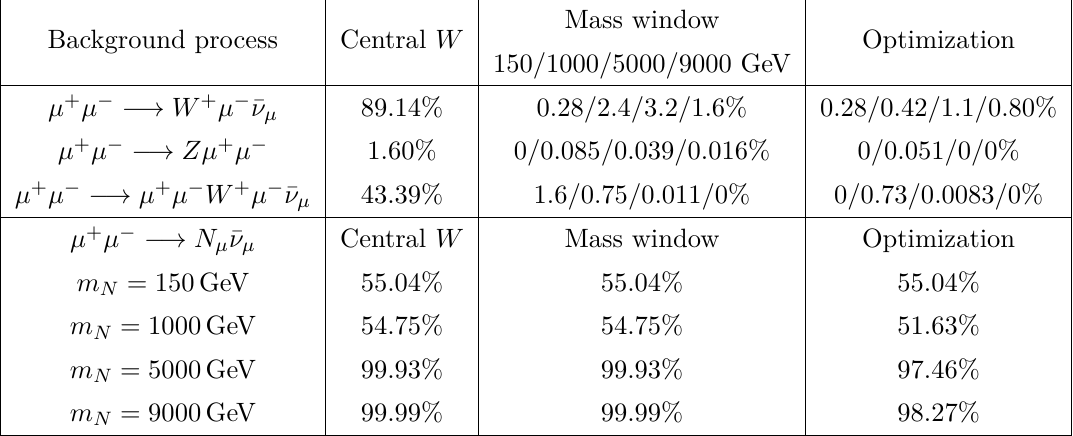
Table 15 . Cutflow table for N µ at 10 TeV. All processes after pre-selection is set to